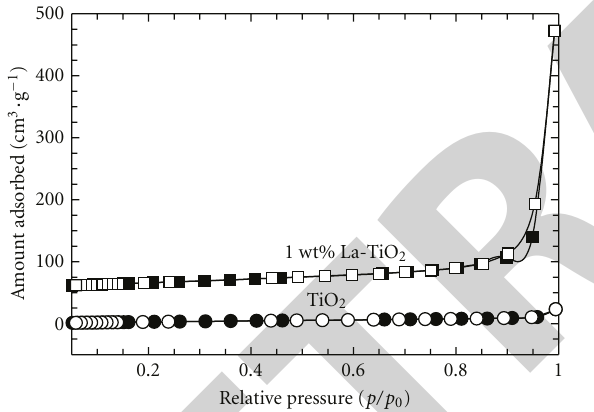
Figure 3: Nitrogen adsorption-desorption isotherms of TiO 2 and 1wt% La-doped TiO 2